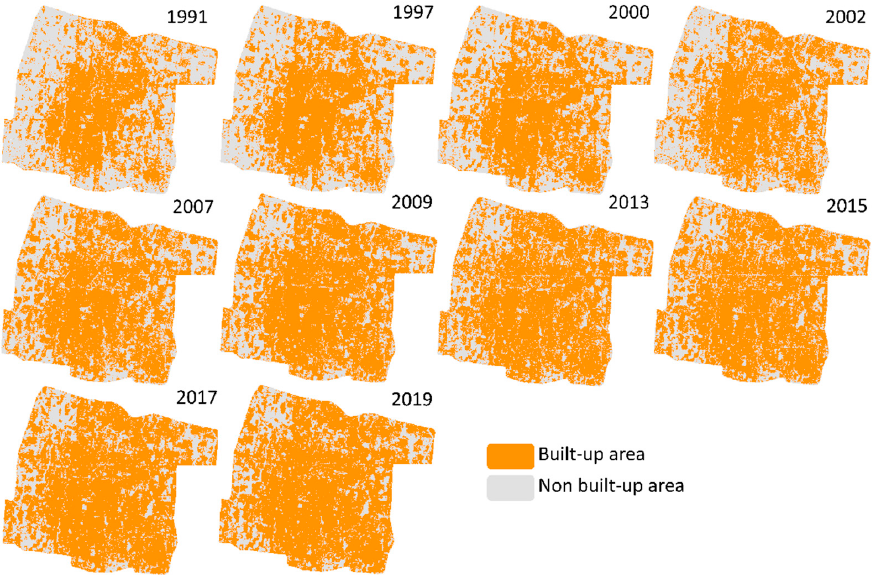
Figure 4. Land cover classification of built-up and non built-up area using SVM classifier based on Landsat images.